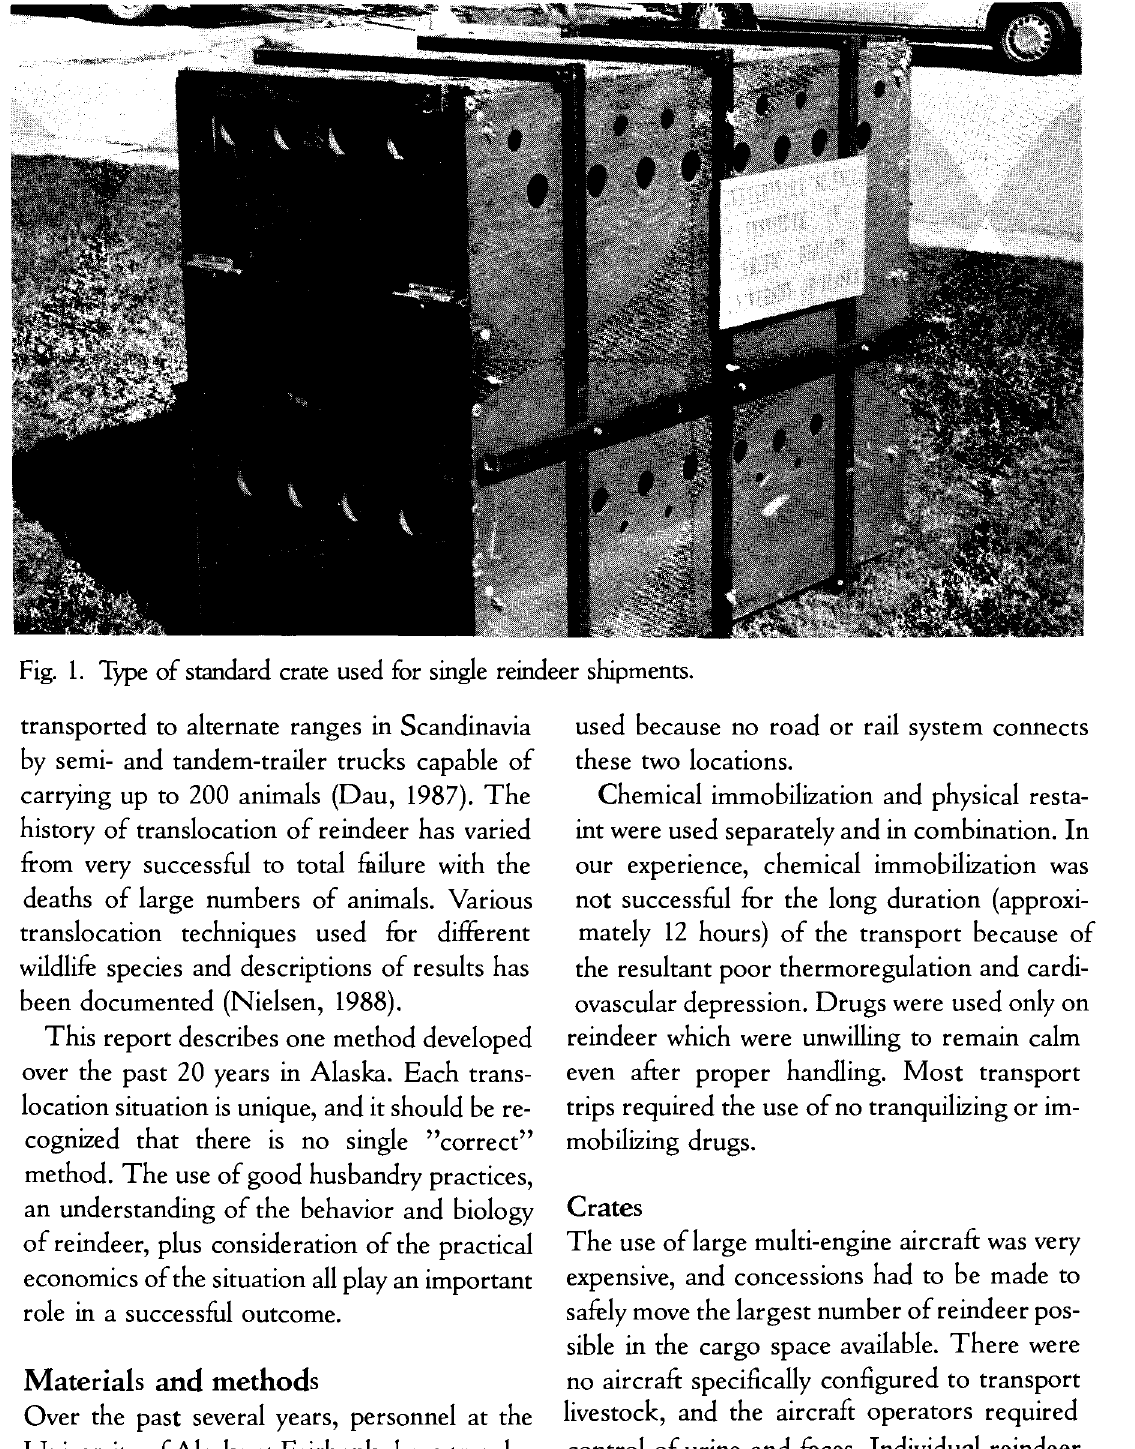
Fig. 1. Type of standard crate used for single reindeer